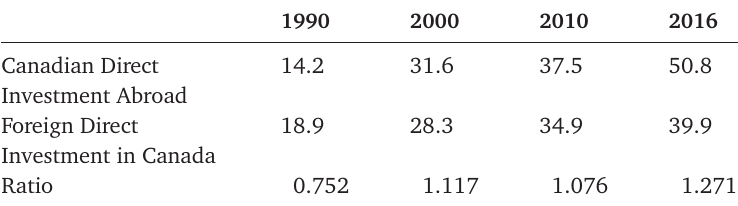
Table 7. Foreign Direct Investment (Inbound, Outbound) as Percentage of